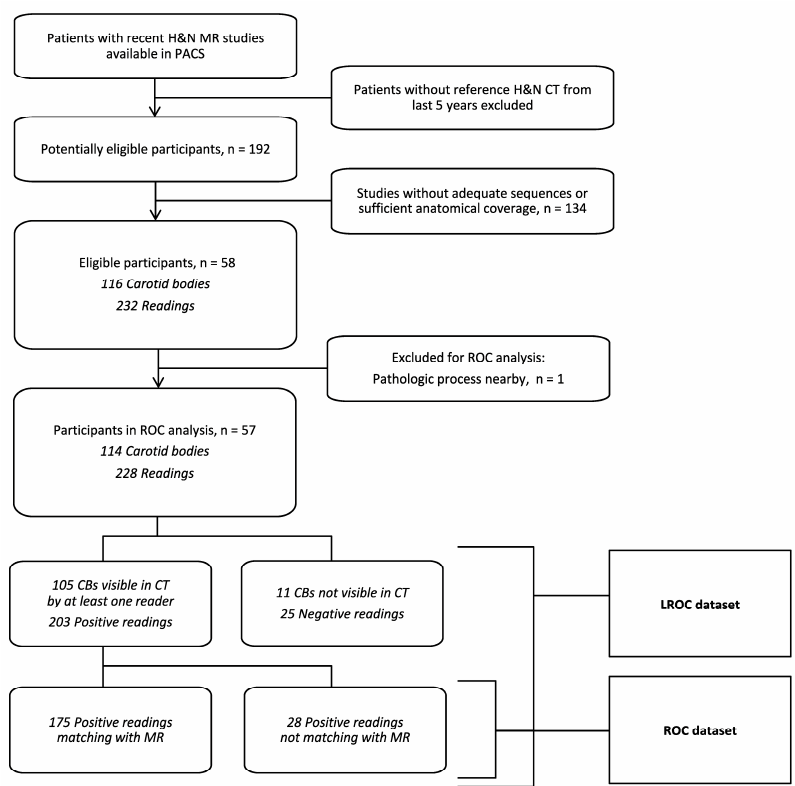
Figure 3. Flow chart. Flow chart depicting patient selection process for the ROC/LROC analysis. Table 3. Frequency summary table of the carotid bodies eligible for ROC analysis.